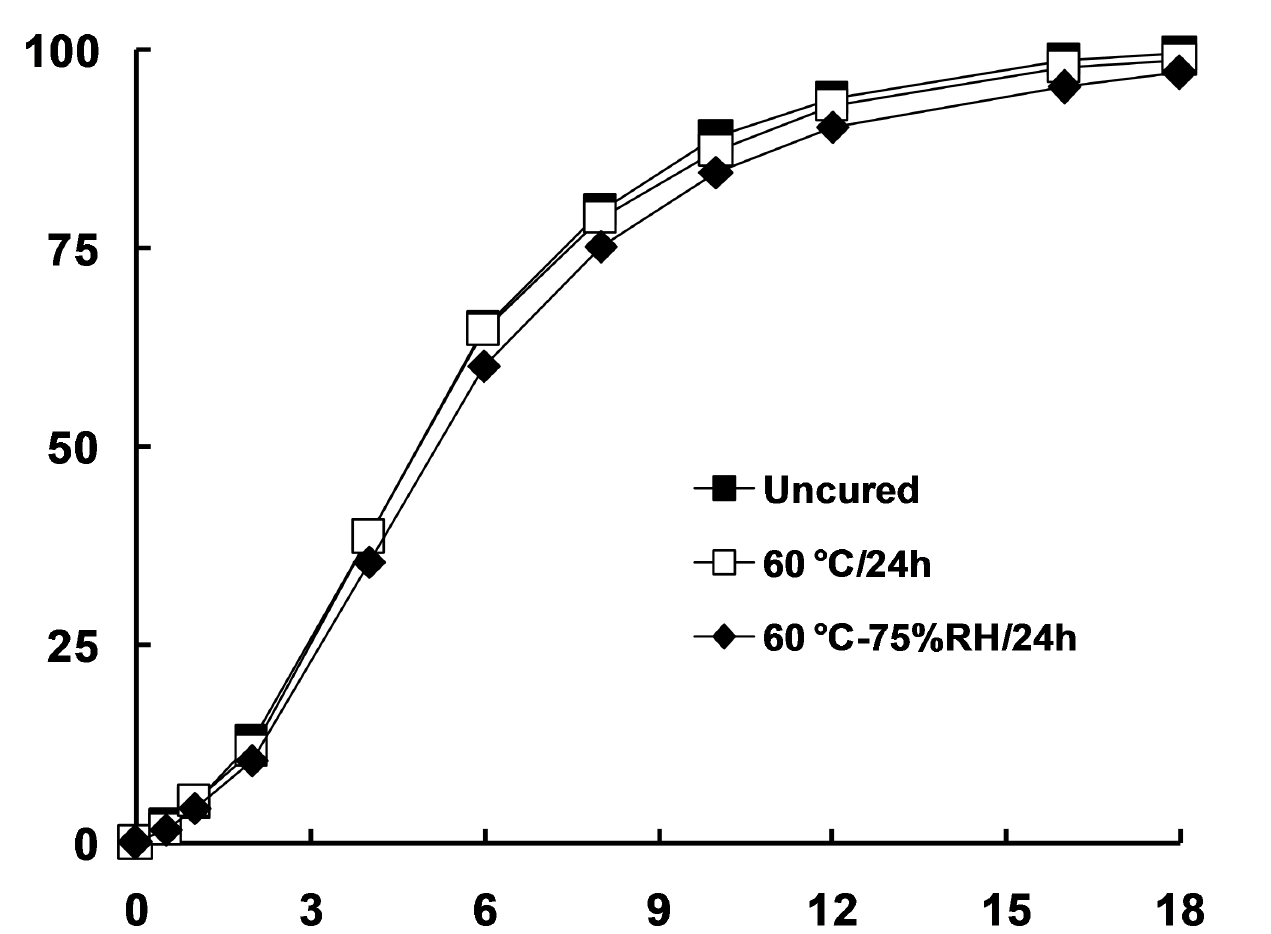
FIGURE 9 - Effect of curing on drug release from pellets based on sugar cores loaded with 10% proranolol HCl and coated with a polymer blend of Eudragit ® NE 30D: Aquacoat ® ECD (25:75) using 35% talc, coating level